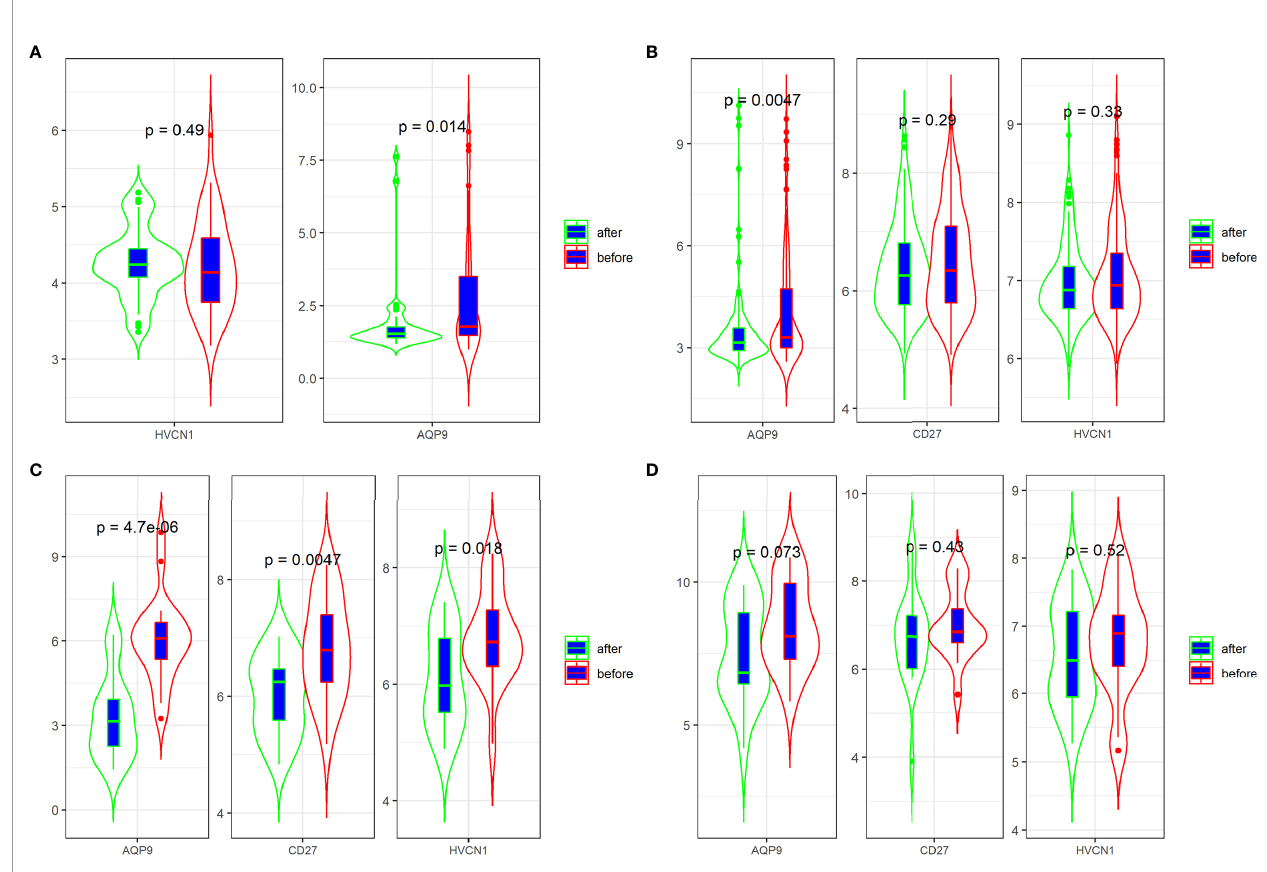
FIGURE 4 | Expression of AQP9 , CD27 and HVCN1 in CD tissues that underwent anti-TNF a therapy (A) Expression of AQP9 , CD27 and HVCN1 in GSE98820 (this dataset do not has CD27 gene); (B) Expression of AQP9 , CD27 and HVCN1 in GSE112366; (C) Expression of AQP9 , CD27 and HVCN1 in GSE16879 (only